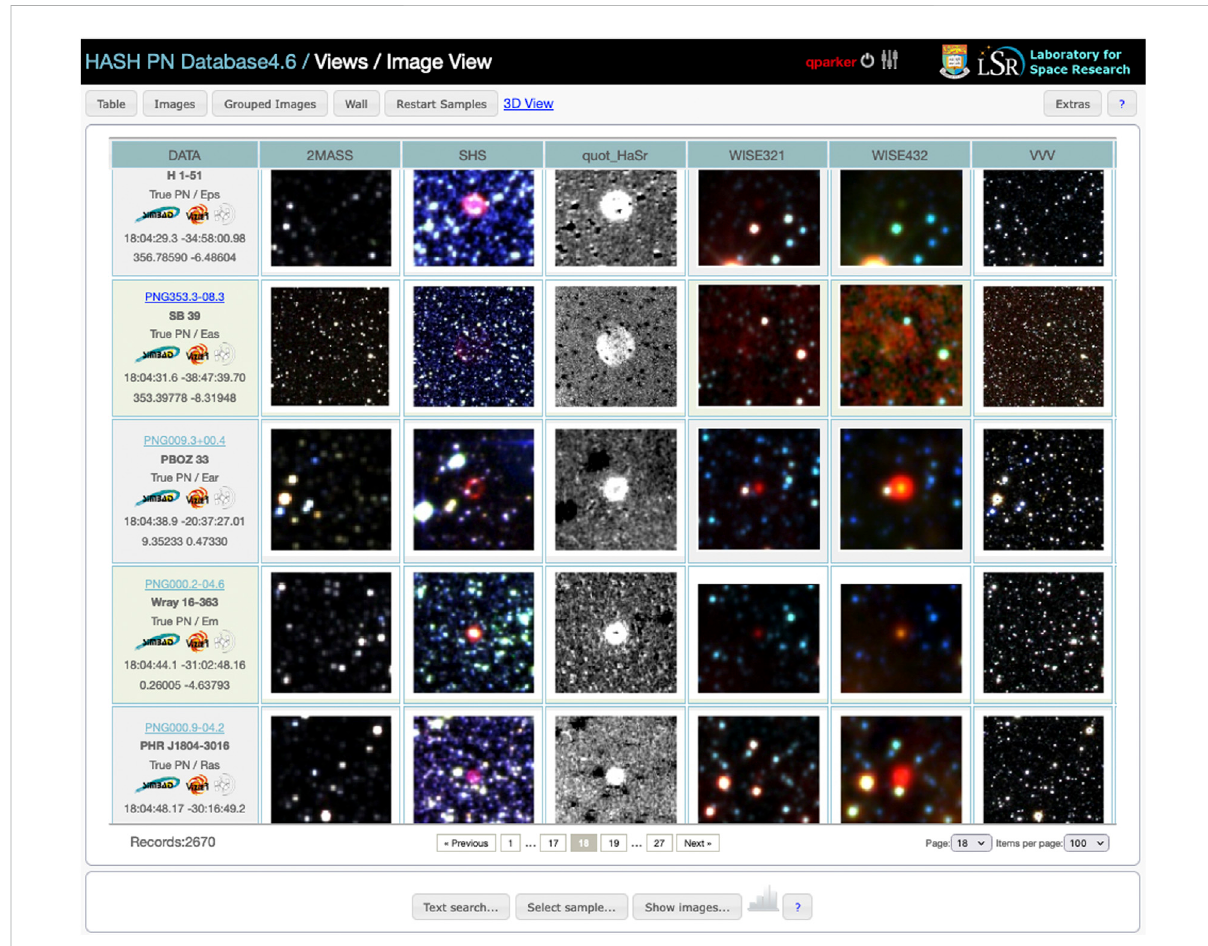
FIGURE 8 ExcerptfromtheHASH database ofseveral “ True ” Galactic PNeinimagingmodewhere userselected, multi-wavelengthimagescanbeplotted for each PNe, row by row. Up to 48 such images are available for selection from 25 different surveys. Only fi ve of the 2670 rows available here for ‘ T ’ Galactic PNe are